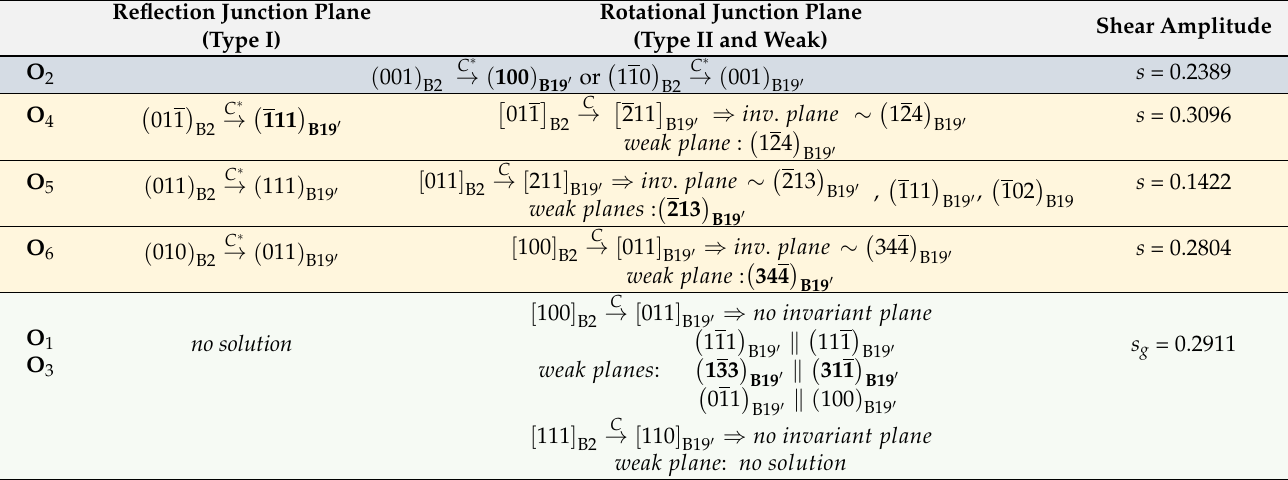
Table 3. Junction planes and twin characteristics predicted by the inter-correspondence operator O i between the B19 (cid:48) variants. We indicate, for the type I twins, the B2 reflection plane and the B19 (cid:48) twin plane (junction plane) and, for the type II twins, the B2 180 ◦ axis and the B19 (cid:48) twin axis. The invariant but irrational plane K 2 is written by a rational approximate tagged by a symbol ∼ . The arrows mean both “correspondence” and “parallelism”. The junction planes that agree with the observations (Section 5.4) are written in